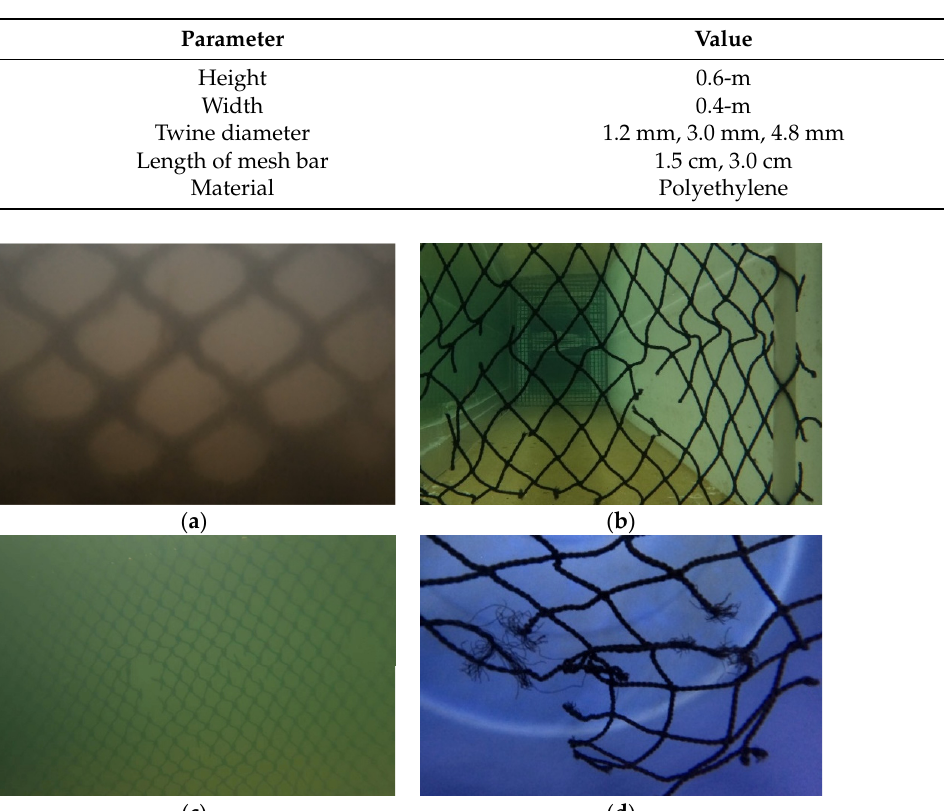
Table 1. Structural parameters of the test netting.